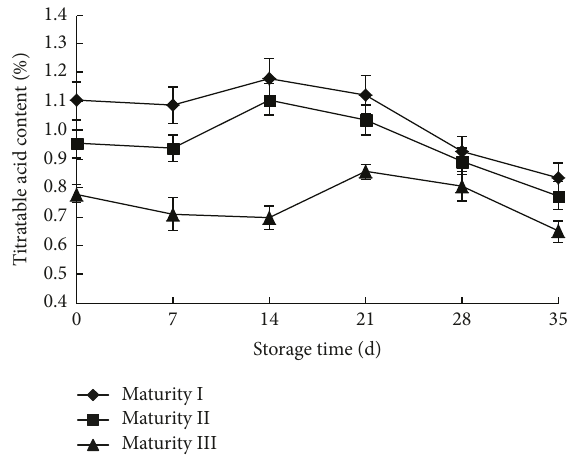
Figure 5: Effects of harvest maturity on TA content in apricots; fruits with maturity class I (colored area < 50%), maturity class II (colored area 50–80%), and maturity class III (colored area > 80%) were categorized according to the yellow conversion rate. Vertical bars represent the standard errors of the means of triplicate replicates.